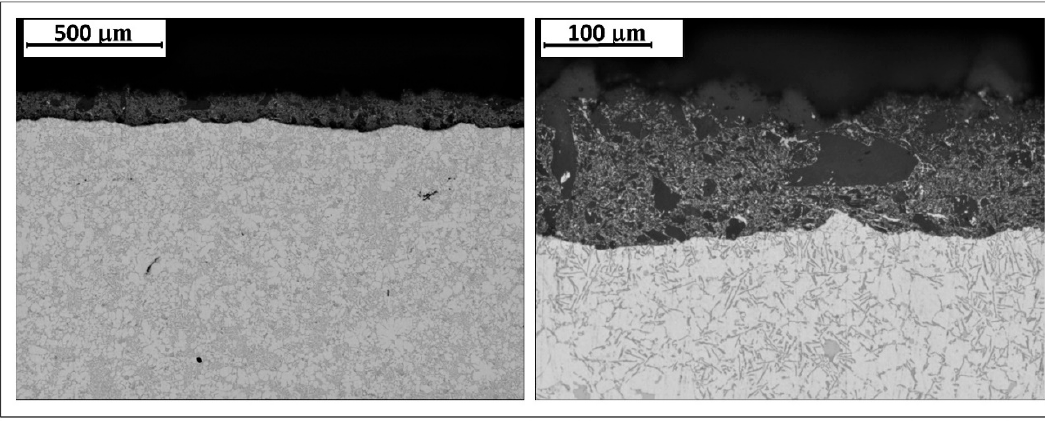
Figure 14. Optical microscope details of the transverse sections of the hollowed crossbeam.